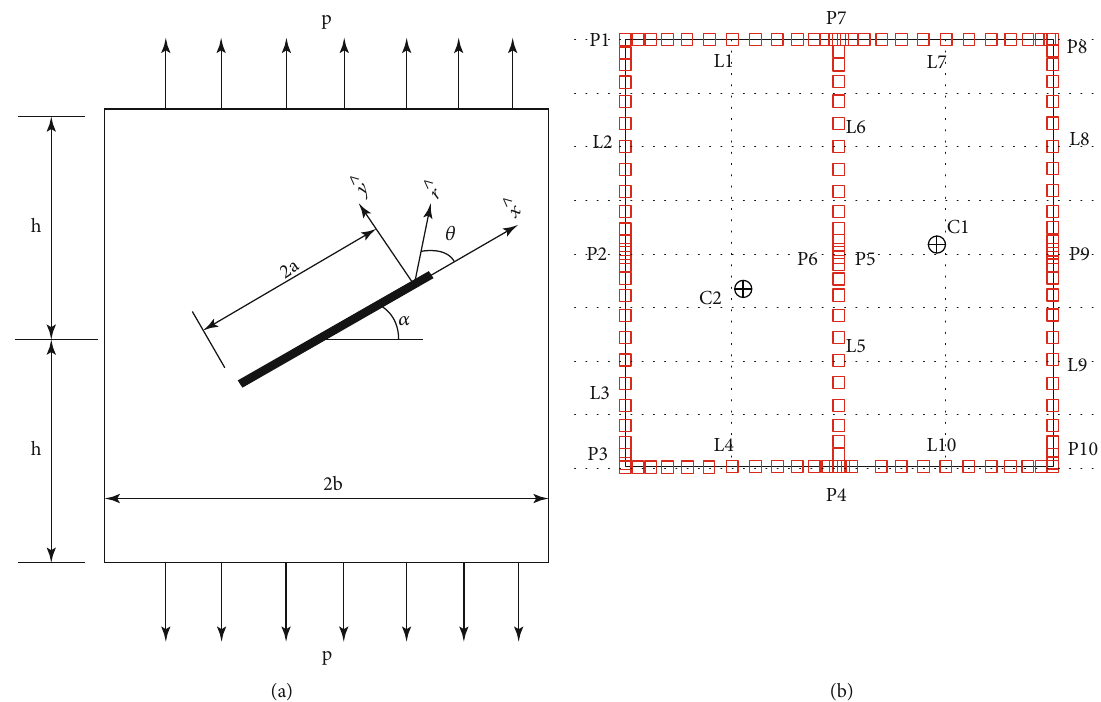
Figure 3: A rectangular plate with an angled crack [50]: (a) geometry; (b) mesh of 14th-order elements.